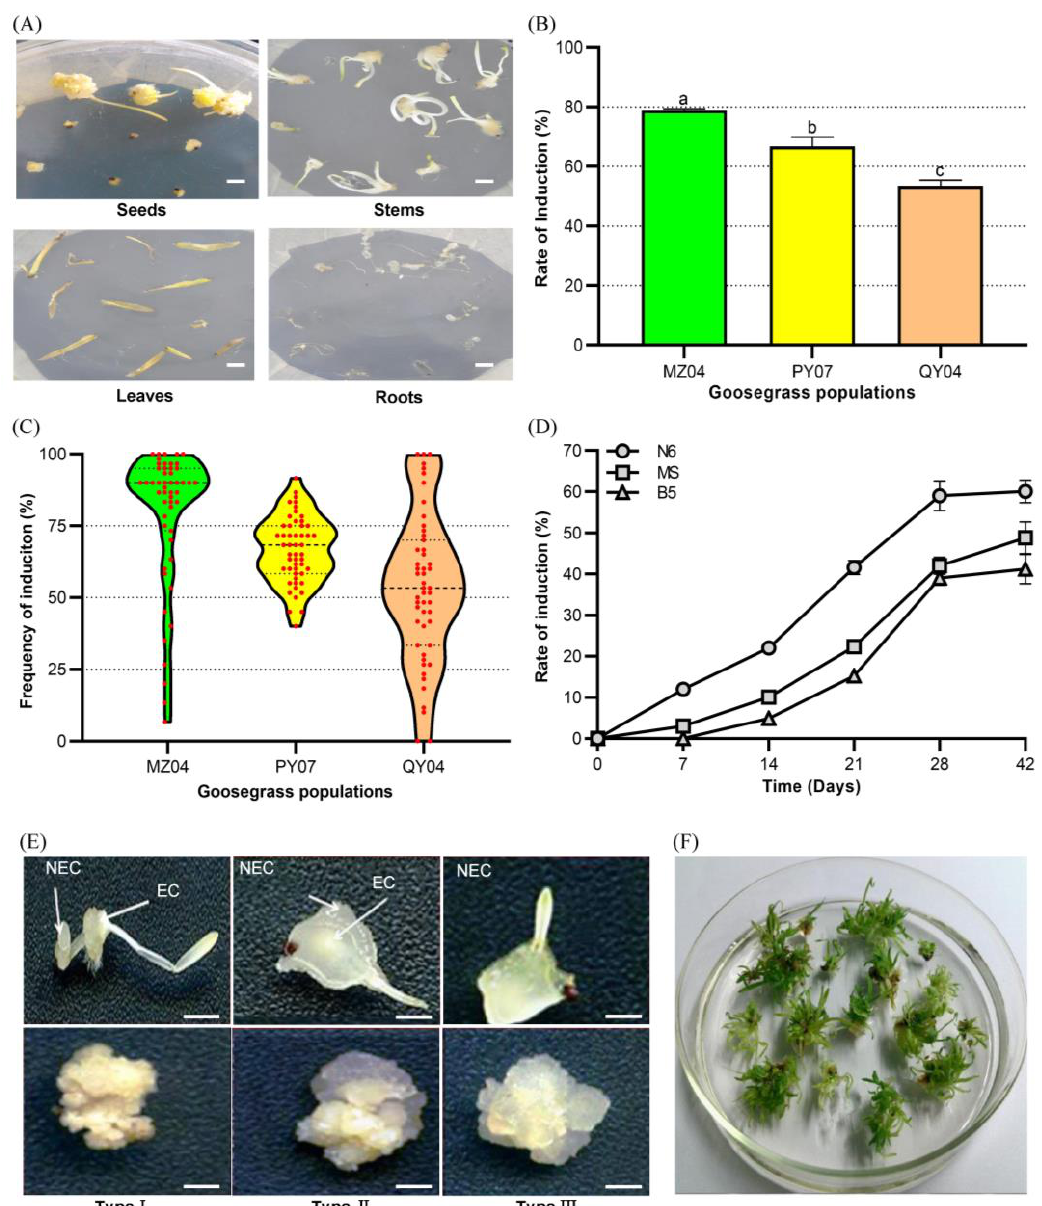
Figure 1. The callus induction for goosegrass. ( A ) Effects of the seeds, stems, leaves, and roots of goosegrass as explants for callus induction. Scale bars, 0.5 cm. ( B ) The average efficiency of callus induction of seeds from three paraquat-sensitive goosegrass biotypes. Different letters indicate significant differences at p < 0.05. ( C ) The distribution of frequency of callus induction from seeds of the three biotypes. ( D ) The efficiency rates of callus induction from MZ04 seeds in N6, MS, and B5 media. ( E ) The morphology of the primary calli of the types I to III recognized by the texture. EC means embryogenic calli and NEC non-embryogenic calli. Scale bars, 0.5 cm. ( F ) The high-efficiency differentiation was from the types-I calli of